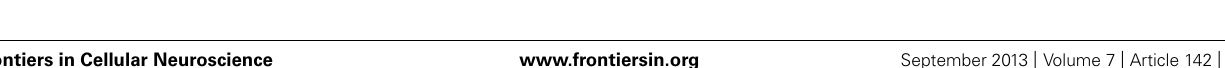
Frontiers in Cellular